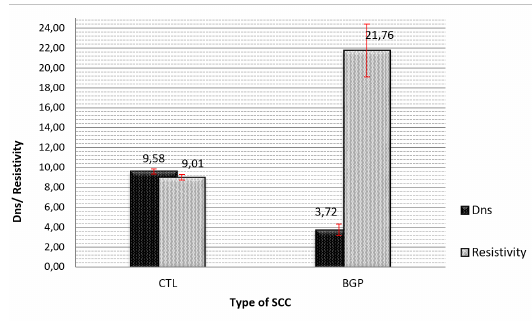
Figure 9. Chloride ion penetration test